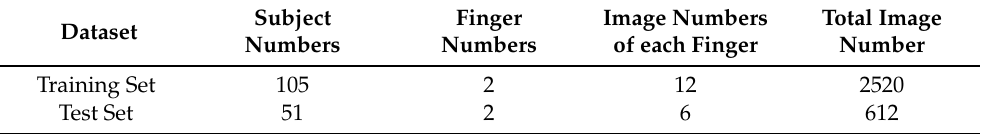
Table 1. Dataset division and